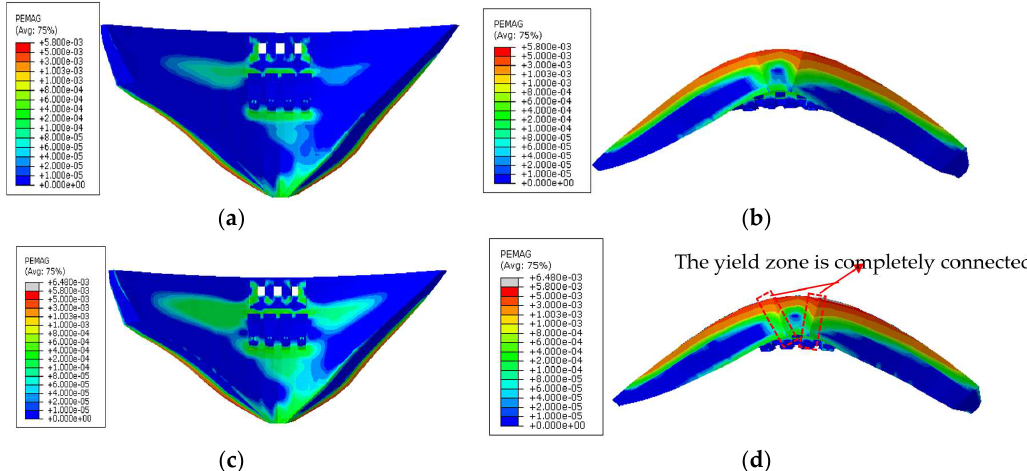
Figure 11. The yielding region under different analysis cases (PEMAG: plastic strain magnitude). ( a ) Downstream surface under case 8; ( b ) foundation surface under case 8; ( c ) downstream surface under case 9; ( d ) foundation surface under case 9.